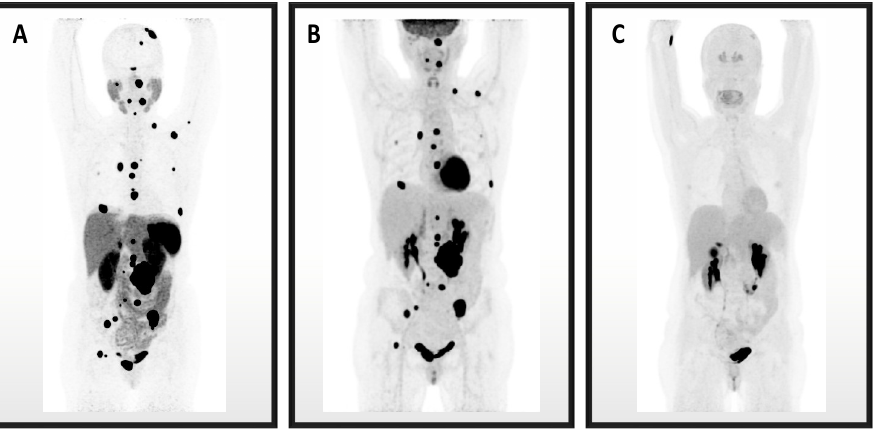
An imaging comparison of 68 Ga-DOTATATE, 18 F-FDG, and 18 F-FDOPA PET images is depicted in Figure 1.